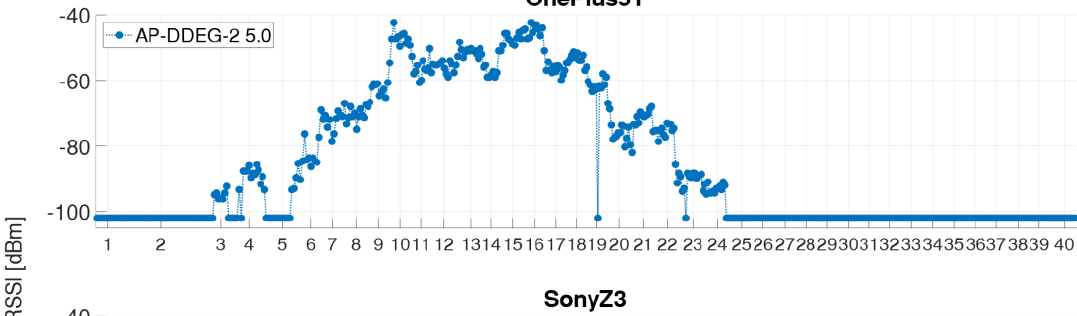
Figure 3. Linear interpolation of the kinematic measurements for the two smartphones ( top ) OnePlus 5T and ( bottom ) Sony Z3 which measured simultaneously.